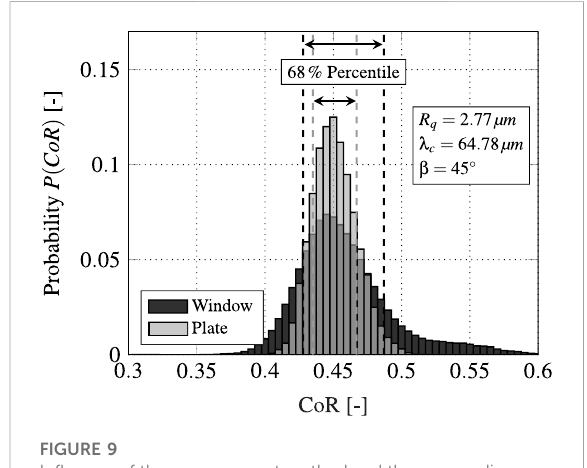
FIGURE 9 In fl uence of the measurement method and the surrounding fl uid fl ow on the CoR within the numerical